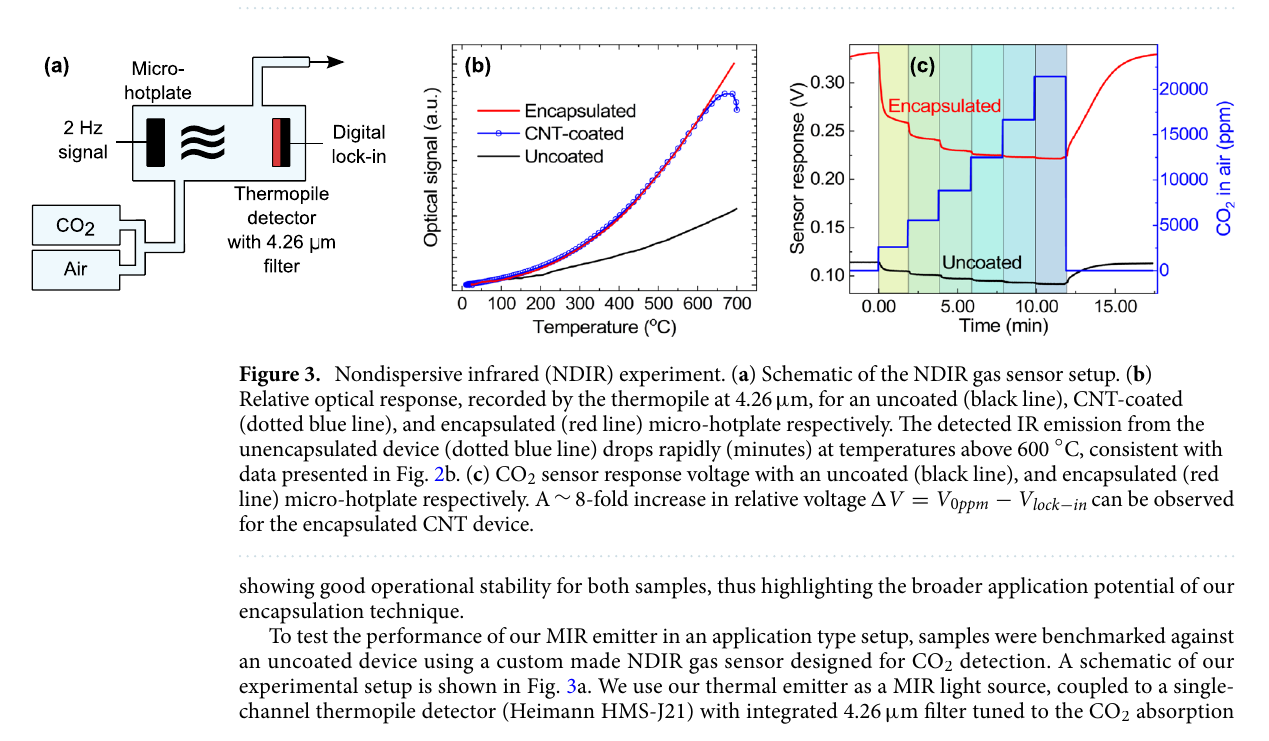
Figure 2. Characterization and stability tests in air. ( a ) Infrared absorption spectra of an uncoated micro- hotplate (black line) compared to that of a CNT-coated plate (red line) absorbing almost all light. ( b ) Emission spectra measured at 600 ◦ C for an uncoated (black line), CNT-coated (blue line), and encapsulated (red line) micro-hotplate, respectively. CNT-coated devices show a ∼ 8-fold emission increase when compared to uncoated devices at equivalent temperature, however, unencapsulated CNTs burn-off within minutes, resulting in their emission spectrum (blue line) falling from an initial value close to that of an encapsulated device (red line) to that of an uncoated device (black line). Optical inspection (inset) shows CNTs have almost entirely burned-off. ( c ) Emission spectra measured at 600 ◦ C over a 10-day period, for a device with encapsulated NH 3 :C 2 H 2 -synthesised CNTs (shown in Fig. 1f). Optical images recorded at respective times show encapsulated CNTs are not affected by the high temperature operation. An optical image of a test sample after operating at a much higher, 850 ◦ C, temperature for 4 hours is presented in the bottom-right corner, showing the CNTs are intact. ( d ) (bottom two lines) Raman spectra measured at 532 nm before and after the operation stability test presented in ( c ). As a comparison, the top two lines show the Raman spectra measured for the same test (not shown) done with H 2 :C 2 H 2 -synthesised CNTs (shown in Fig. 1h) instead, showing both samples remain stable.